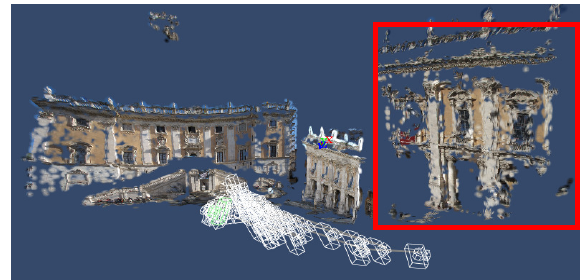
Figure 4. Campidoglio Square, Rome, Automatic Reconstruction